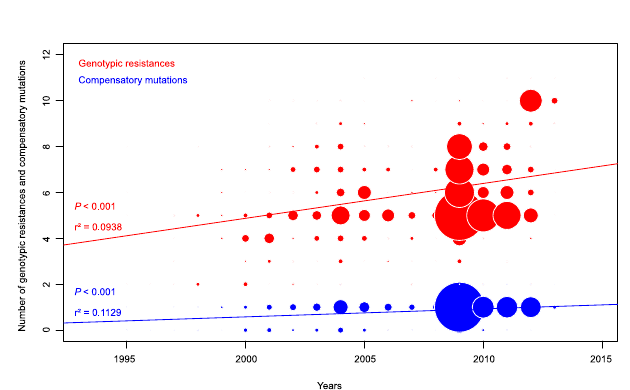
Fig. 4 | Bubble plot showing the number of genotypic resistances (in red) and compensatorymutations(inblue)asafunctionofstrain ’ syearsofisolationof allW148strains( n =720). Bubblesizesareproportionatetothenumberofstrains. Regression analyses (least square approximation) were signi fi cant ( P <2.2×10 − 16 ) and regression curves are shown on the